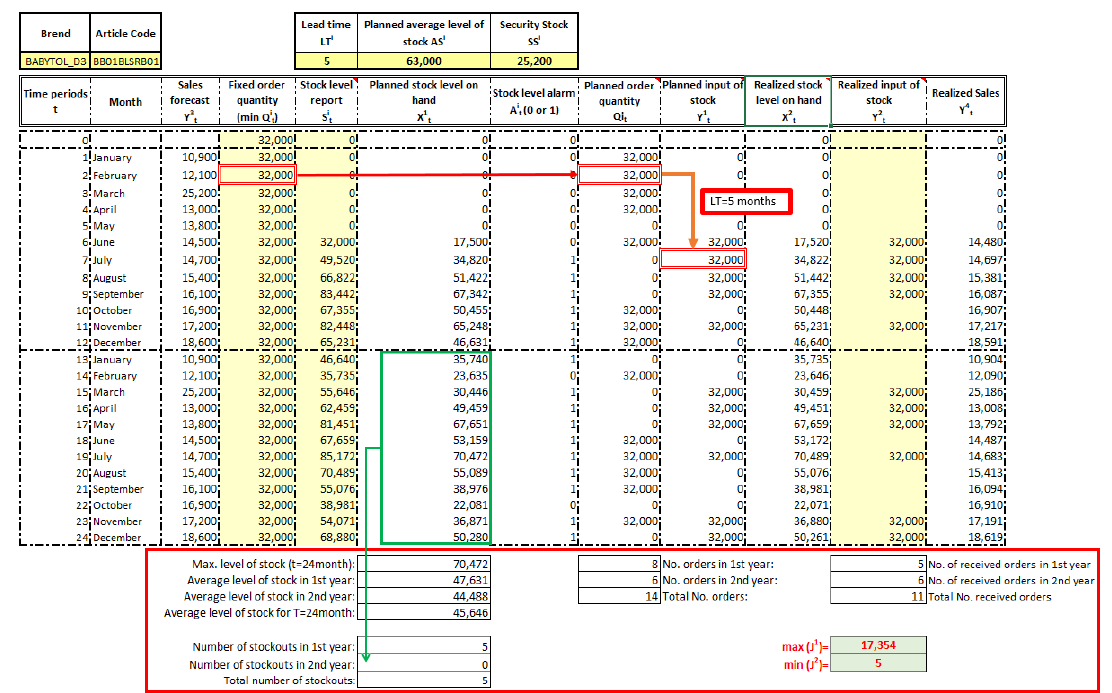
Figure 8. Elements of the spreadsheet model for Case 2: FOQ policy with stochastic demand.